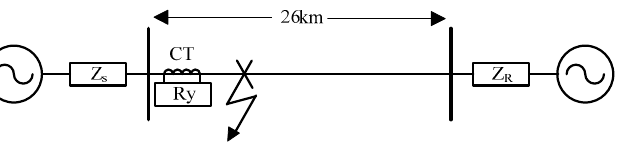
Figure 5. The transmission line, modeled with sources at both ends .